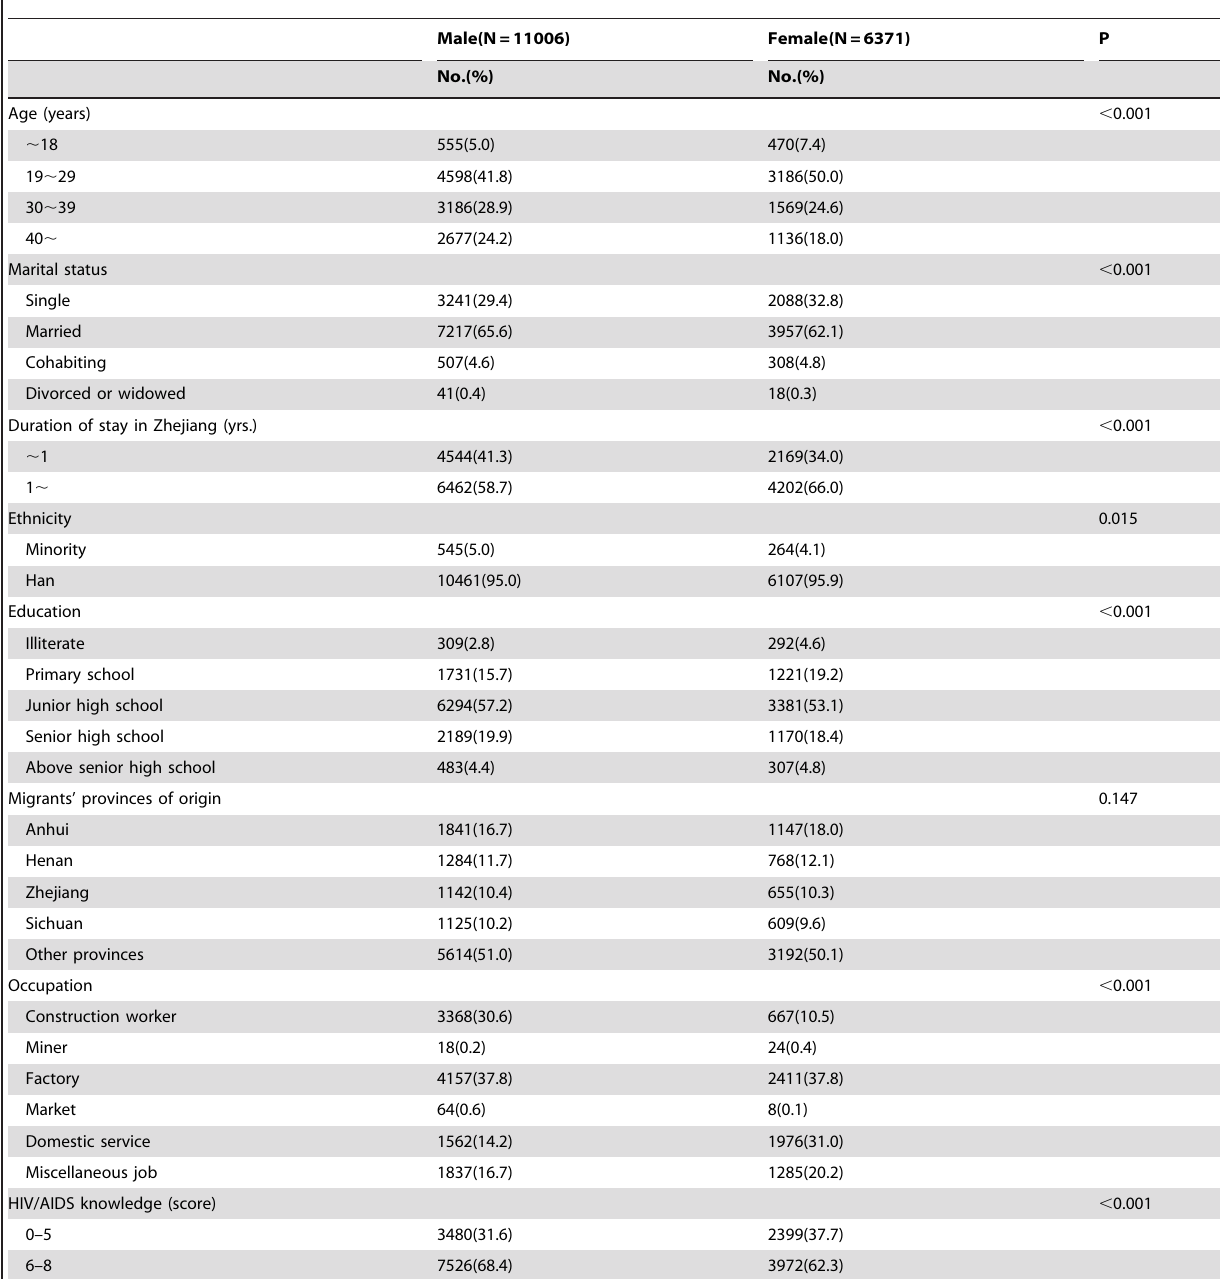
Table 1. Socio-demographic characteristics and HIV/AIDS-related knowledge by